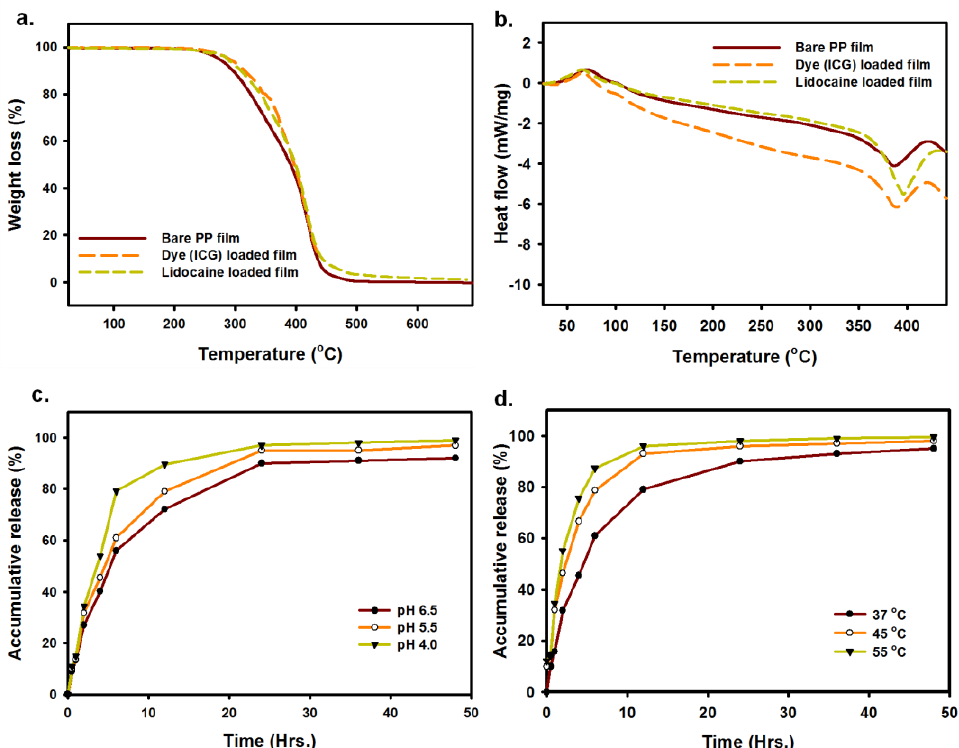
Figure 2. ( a ) TGA (thermogravimetric) studies of bare PP film, dye (ICG)-loaded film, and lido- caine-loaded PP film. ( b ) DSC analysis of bare PP film, dye (ICG)-loaded film, and lidocaine-loaded PP film. ( c ) In vitro pH-dependent (%) cumulative release of lidocaine from drug-loaded PP film at pH 4.0, 5.5, and 6.5. ( d ) In vitro temperature-dependent (%) cumulative release of lidocaine from drug-loaded PP film at 37 °C, 45 °C, and 55 °C at pH 5.5.